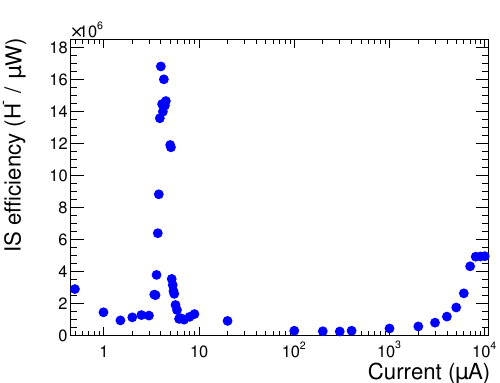
Figure 9. Negative hydrogen yield efficiency versus ion source discharge current.